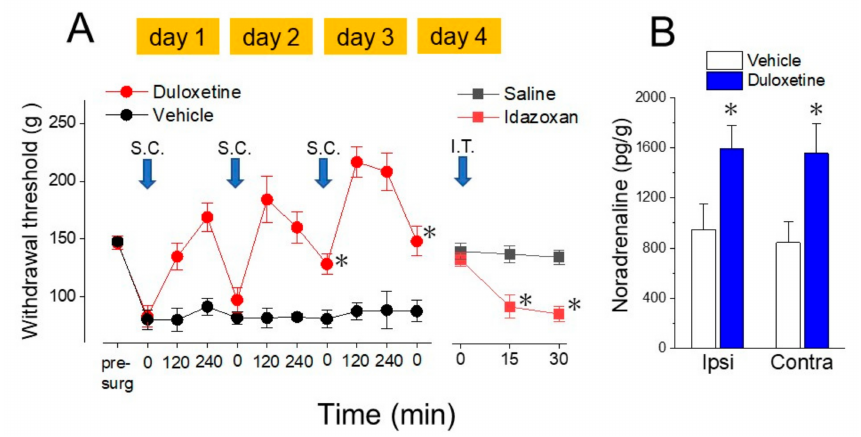
Figure 2. Antihyperalgesic effects of duloxetine in rats after nerve injury by noradrenaline increase in the spinal cord. ( A ) Effects of three daily injections of duloxetine on hind paw mechanical hyperalgesia after spinal nerve ligation (SNL) in rats. Rats were administered duloxetine (10 mg/kg/day, subcutaneous injection) or vehicle for three consecutive days. Each day, withdrawal thresholds in ipsilateral hind paw were measured at time 0 (baseline: before each duloxetine injection), and 120 and 240 min after the injection. Three daily treatment increased baseline withdrawal thresholds (time 0) of on days 3 and 4 than on day 1 (* p < 0.05 compared with the duloxetine group at time 0 on day 1). Acute antihyperalgesic effects until 240 min after injection were also observed. Then, rats were injected intrathecally (i.t.) with idazoxan, an α 2 -adrenoceptor antagonist (30 µ g/20 µ L) or vehicle. The injection of idazoxan reversed the antihyperalgesic effect of duloxetine (* p < 0.05 compared with the vehicle group at each time-point). ( B ) Spinal cord tissue from SNL rats injected with duloxetine (10 mg/kg/day) or vehicle for three consecutive days was homogenized, and the noradrenaline content was measured. Noradrenaline was increased with duloxetine treatment at both ipsilateral and contralateral to the SNL compared to the vehicle group (* p < 0.05). Data in this figure published from Ref. [27].